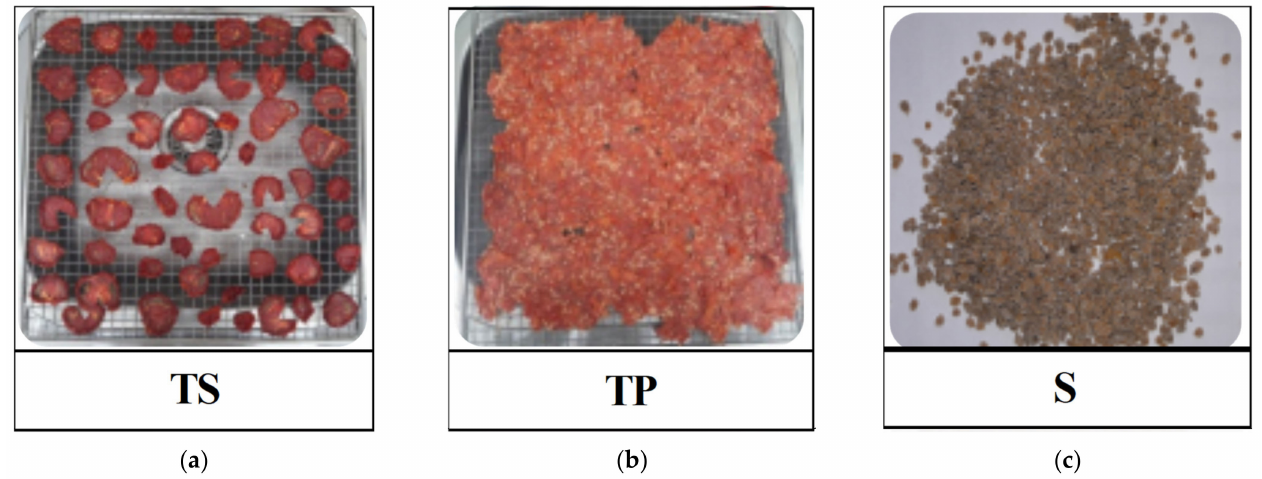
Figure 1. Dried tomato samples: ( a ) tomato slices (TS); ( b ) tomato pomace (TP); ( c ) tomato seeds